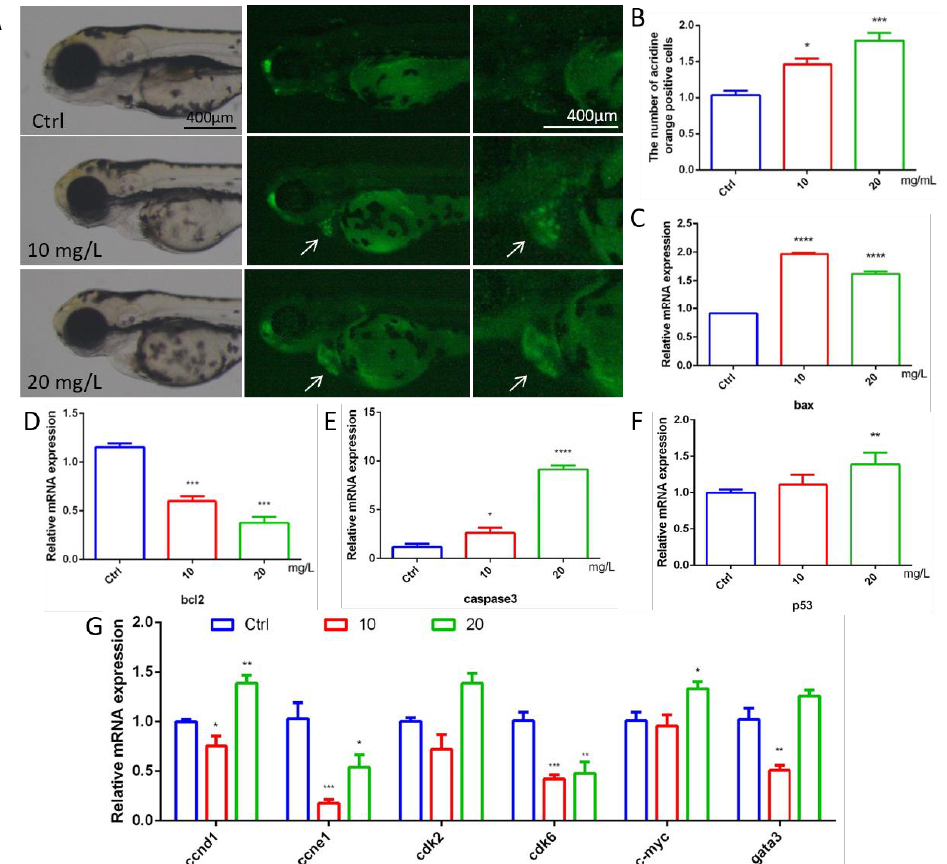
Figure 3. Apoptosis assessment and expression of cycle-related genes in 72 hpf zebrafish. ( A ) Fluores- cence image of zebrafish after acridine orange staining under 6-BA treatment. ( B ) Quantitative statistics of apoptotic cells in larval hearts after acridine orange staining. Apoptotic cells appear as bright green spots. ( C – F ) The mRNA expression levels of the apoptosis-related genes bax , bcl2 , caspase3 , and p53 . ( G ) Expression of cell-cycle-related genes, including ccnd1 , ccne1 , cdk2 , cdk6 , c-myc , and gata3 . Values are ex- pressed as mean ± standard error (SEM). N = 3. * p < 0.05, ** p < 0.01, *** p < 0.001, **** p < 0.0001.